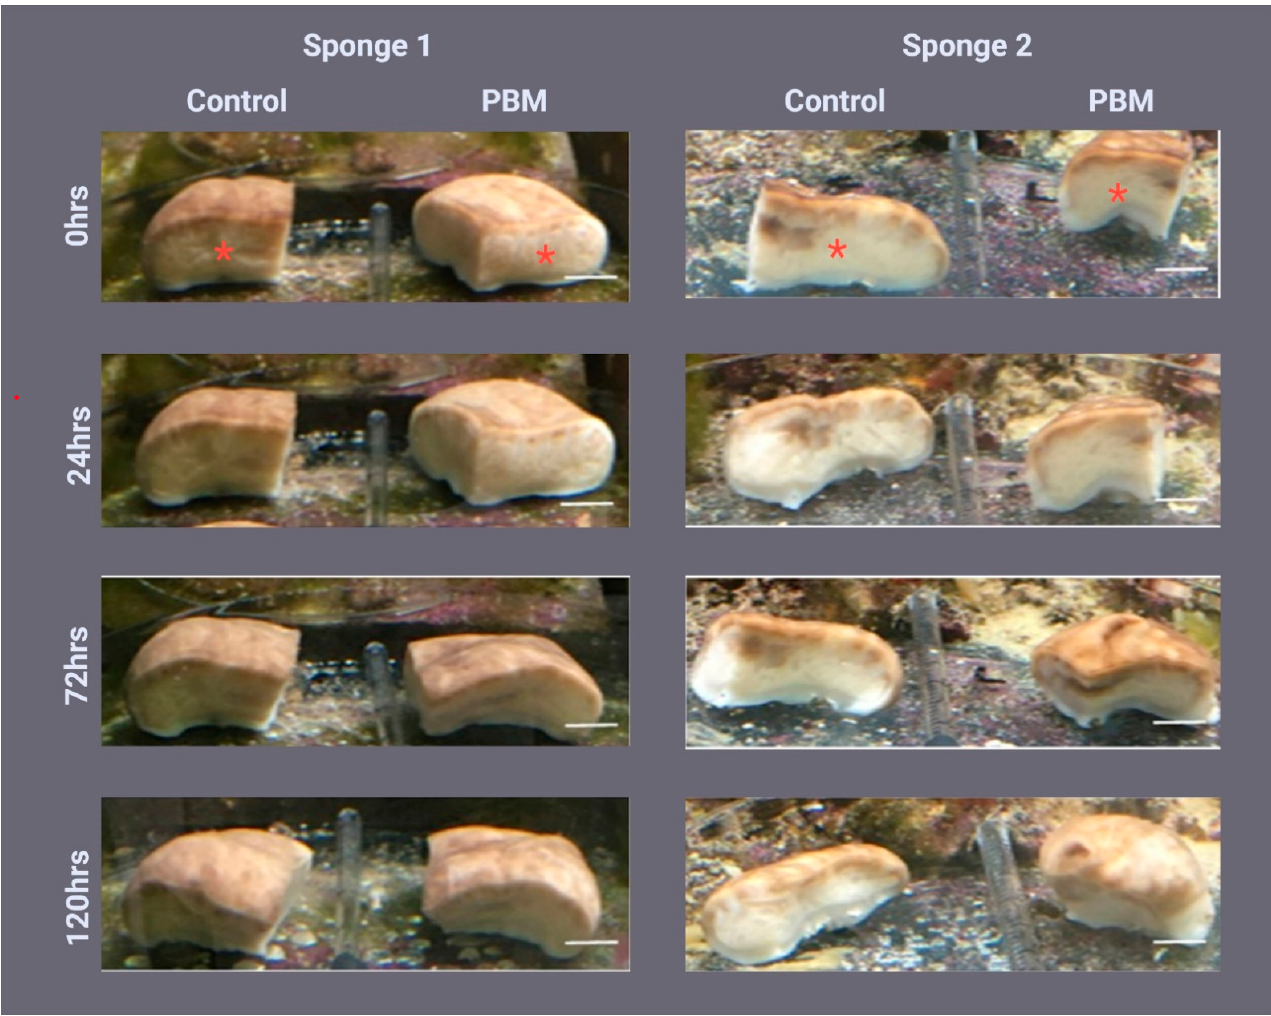
Figure 1. Effect of photo-biomodulation (PBM) on Chondrosia reniformis morphology during tissue regeneration. The regeneration profile of two C. reniformis specimens immediately (0 h) and 24, 72, and 120 h after being cut into four parts, daily irradiated on the regenerating edge with 810 nm-1 W PBM. PBM = samples irradiated with 810 nm-1 W PBM; control = samples irradiated with 810 nm-0 W PBM. Scale bars are 1 cm. The centre of the irradiated area is indicated by the red